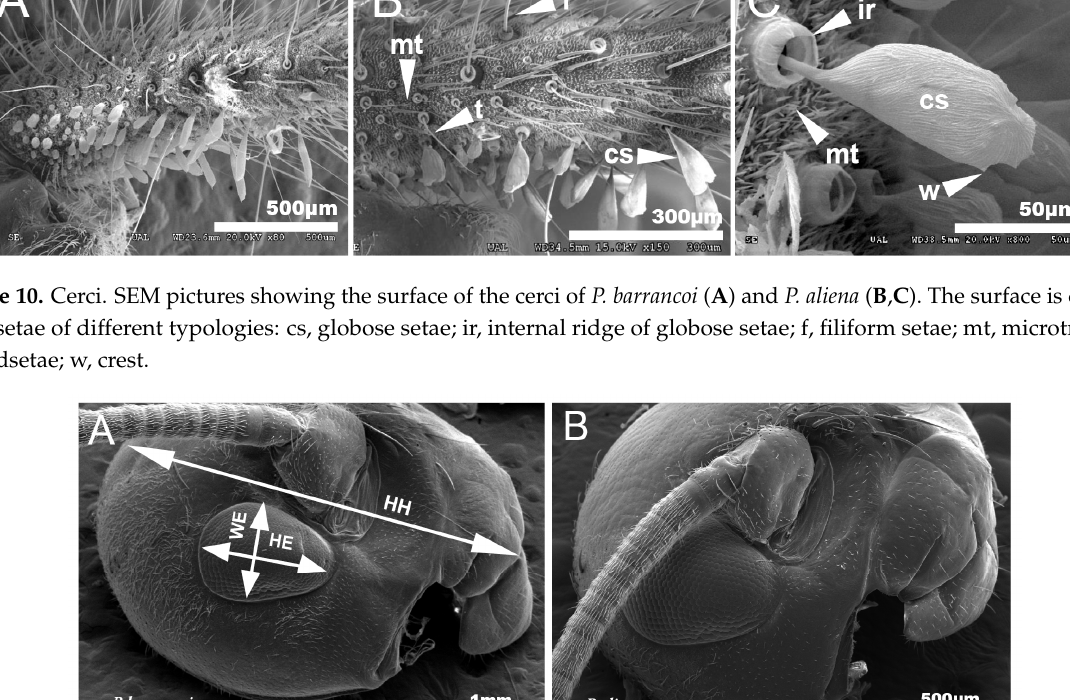
Figure 9. Dorsal glands. SEM pictures showing the dorsal glands in males of the genus Petaloptila ( A – C ). Within the subgenera of the taxon, they appear more developed and with variable structures and characteristics of each species in the subgenus Petaloptila ; in the image, we observe those present in P. aliena ( A ). In the subgenus Zapetaloptila, there is a reduction in the structures, as can be seen in P. barrancoi ( B ). The secretory surface is similar in all cases studied. ( C ) SEM image of the secretory surface in the interguite membrane, P. barrancoi .